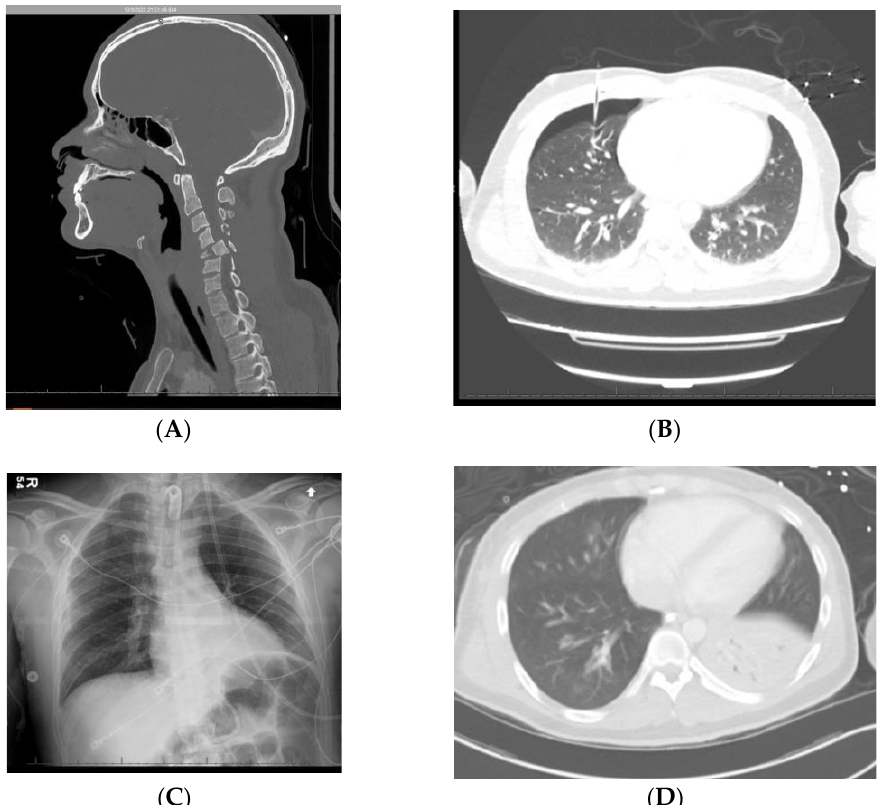
Figure 1. ( A – D ). ( A ) CT cervical spine showing C5 burst fracture and area of spinal cord contusion. ( B ) CT chest showing right pneumothorax with decompression needle in place. ( C ) Chest X-ray showing dilated loops of bowel from opioid-induced ileus raising the left side of the diaphragm. ( D ) CT chest showing left lower lobe consolidation and collapse.